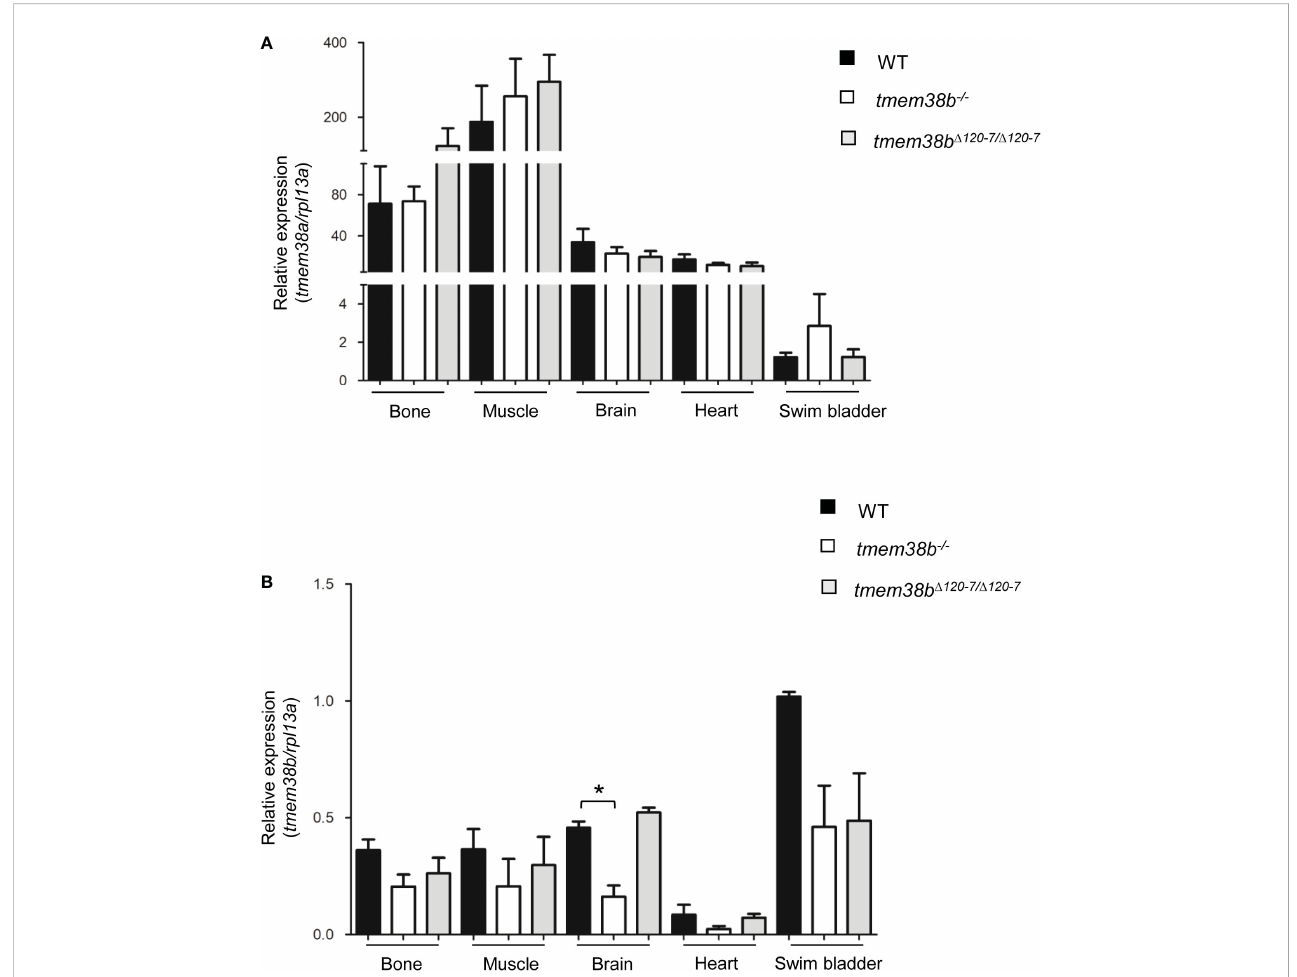
FIGURE 2 Expression analysis of tmem38a and tmem38b in excitable (muscle, brain, heart) and non-excitable tissues (bone, swim bladder) from adult WT and tmem38b mutants. (A) Relative expression of tmem38a . No difference in the transcript level was found between WT and tmem38b mutants by qPCR. (B) Relative expression of tmem38b . qPCR analysis revealed a reduced transcript level in almost all tmem38b -/- tissues respect to WT. Data are expressed as mean ± SEM. *p < 0.05 n = 3 RNA pools per